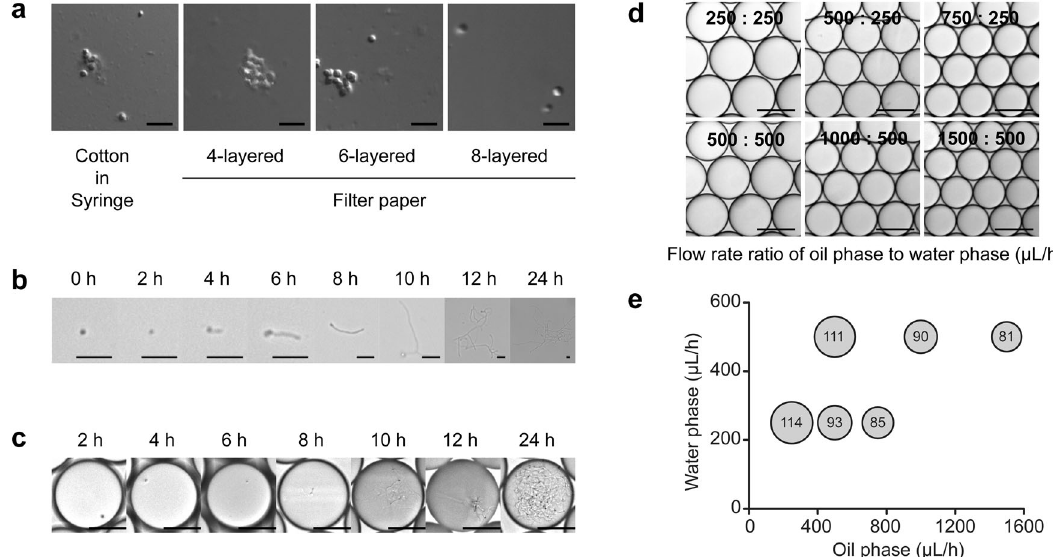
Fig. 1 Preparation and propagation of S. lividans 66 spores in droplets. a Preparation of monodispersed spore suspension. Sterile cotton and four, six, and eight layers of fi lter papers were tested for fi ltering the spore suspension. A monodispersed spore suspension was obtained after fi ltrated through eight layers of sterile fi lter paper. Scale bar: 5 μ m. b Germination of monodispersed S. lividans 66 spores in R2YE liquid medium over 24 h. Scale bar: 10 μ m. c Germination of S. lividans 66 spores in droplets over 24 h. Scale bar: 50 μ m. d Optimization of droplet diameters at different fl ow rate ratios of oil-to-water phase. Scale bar: 100 μ m. e Relationship between droplet diameters and the fl ow rate ratio of oil-to-water phase. The number in the circle indicates the droplet diameter, which was calculated from microscopy images using n = 100